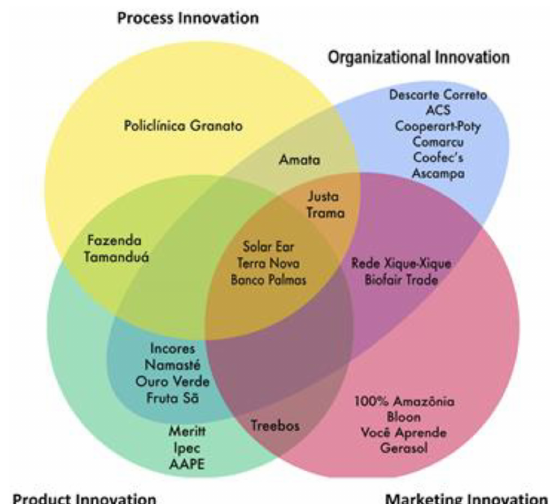
Figure 5. Types of innovation identified from